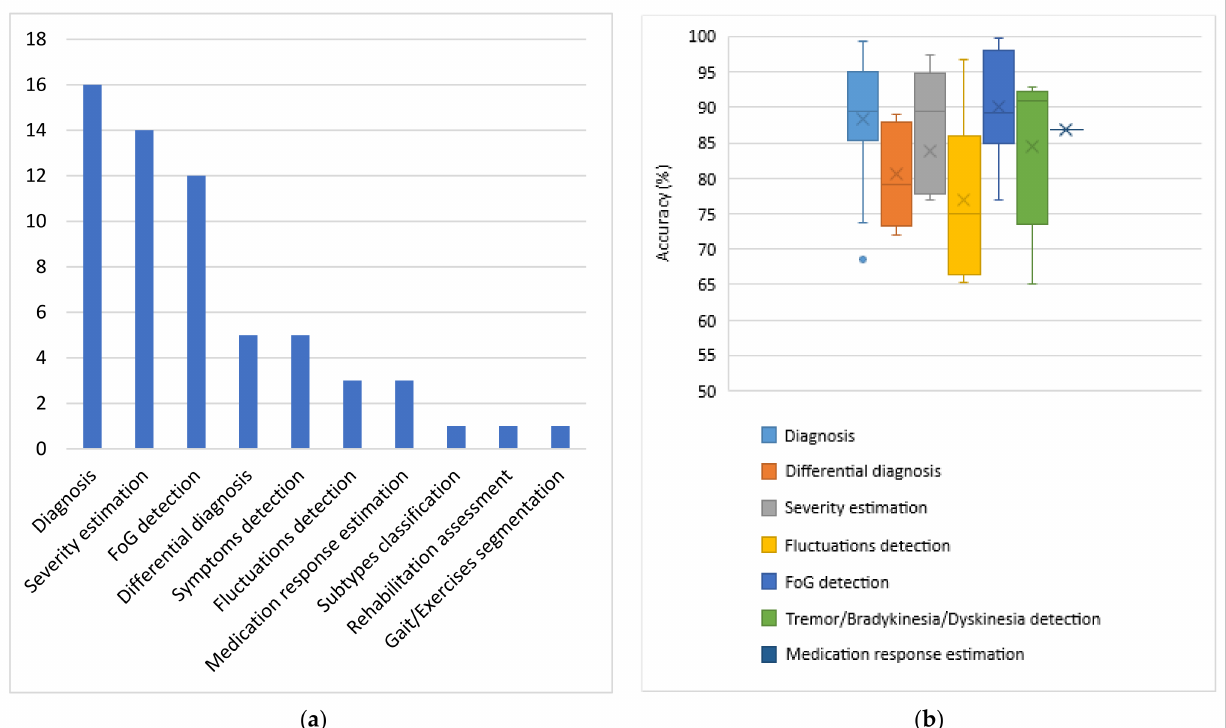
Figure 5. PD problems addressed based on inertial sensors and the respective obtained accuracies. ( a ) Number of studies per task; ( b ) accuracies obtained from the proposed models for each category of addressed tasks. Number of studies considered in this boxplot per task: n = 12 for diagnosis, n = 6 for differential diagnosis, n = 8 for severity estimation, n = 3 for fluctuations detection, n = 11 for FoG detection, n = 4 for tremor/bradykinesia/dyskinesia detection and n = 1 for medication response